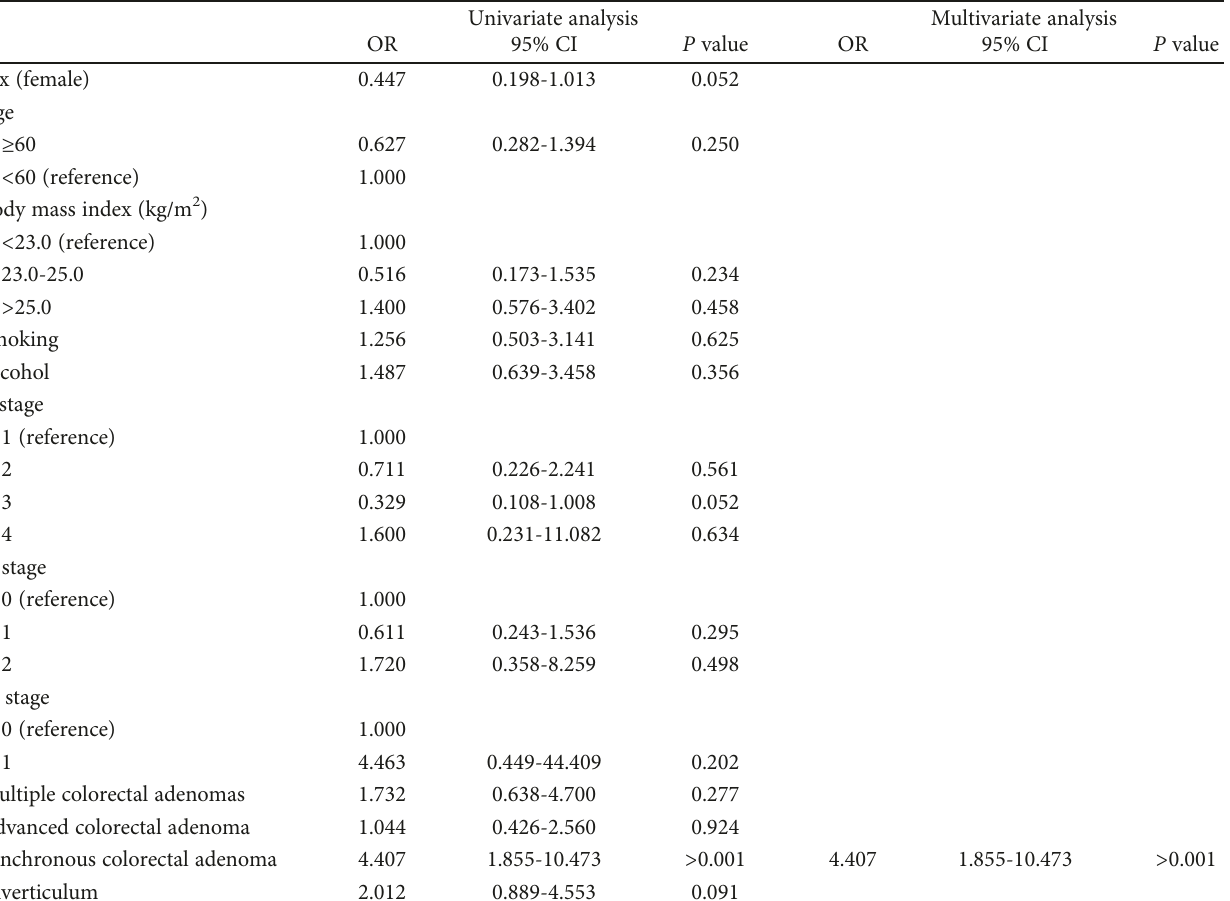
Table 4: Univariate and multivariate analyses for risk of metachronous colorectal adenoma ( n = 106